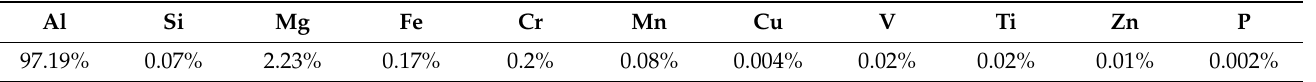
Table 1. Chemical composition of AA-5451.